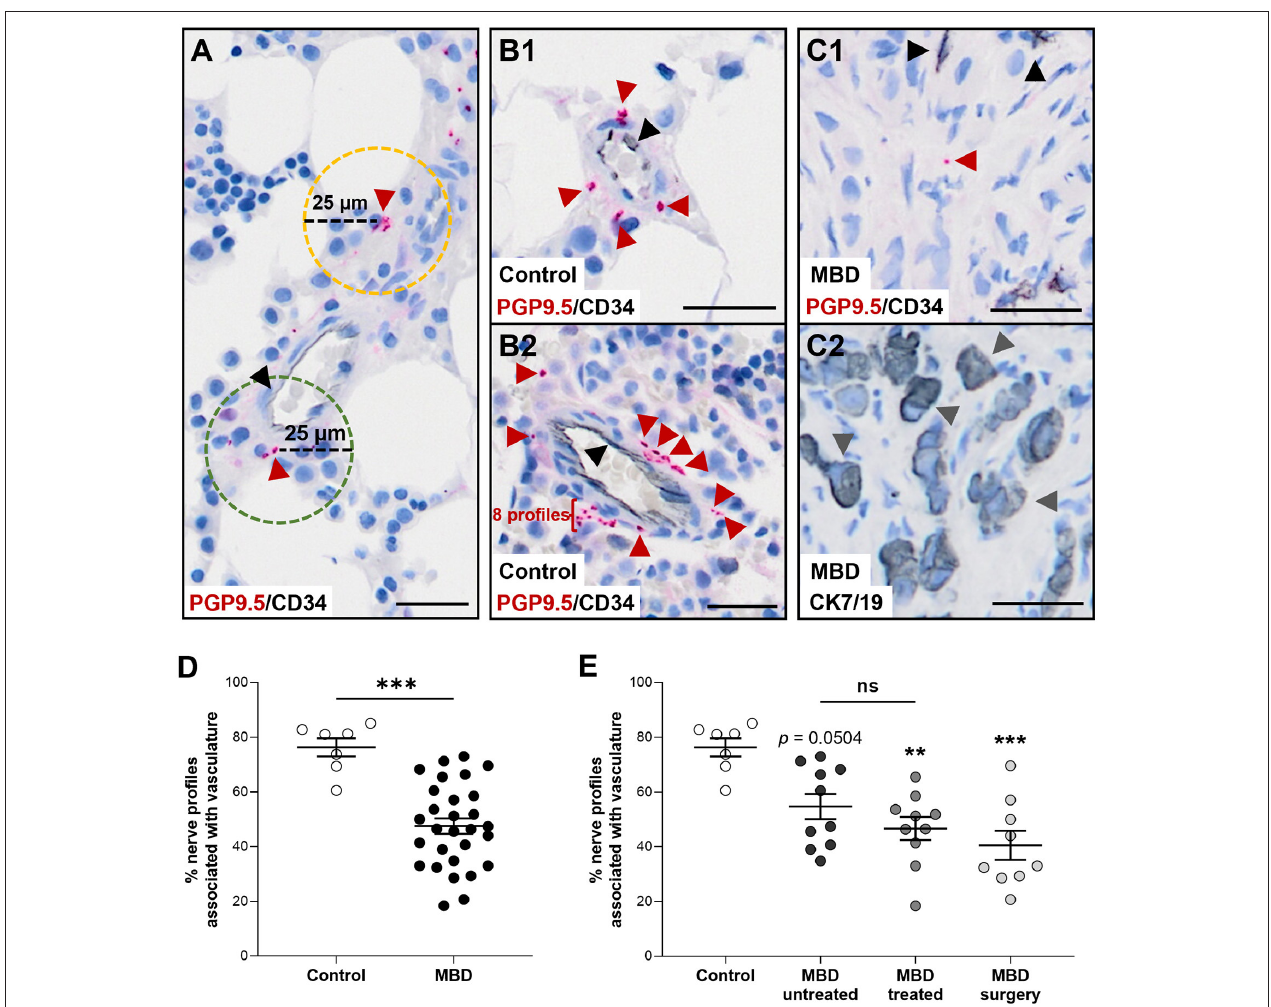
FIGURE 2 | Nerve profiles are less associated with vasculature in cancer-infiltrated bone. (A) For each nerve profile it was determined if it was associated within a distance of 25 µ m (green hatched line) or unassociated (yellow hatched line) with vasculature. (B,C) Representative illustrations of nerve profiles found within 25 µ m of a vascular structure in the bone marrow of human healthy tissue (B1,B2) and the bone marrow of patients with metastatic bone disease (MBD) (C1,C2) . Sections were stained for protein gene product 9.5 (PGP9.5, red arrow heads) and CD34-positive endothelial cells (black arrowheads), while the adjacent section was stained for cytokeratin 7 and 19 [CK7/19, gray arrow heads, (C2) ] to identify cancer cells. (D) The percentage of nerve profiles found proximate to a vascular structure was significantly higher in the healthy bone marrow compared to the cancer-infiltrated bone marrow. (E) Analysis of the three subgroups of cancer-infiltrated bone demonstrated a decreased association of nerve profiles and vascular structures in the MBD treated group and the MBD surgery group compared to controls. The comparison of healthy bone tissue with the MBD untreated subgroup did not reach significance ( p = 0.0504). Comparisons were performed with Mann-Whitney U test or Kruskal–Wallis one-way analysis of variance followed by Dunn’s multiple comparisons test as appropriate. Data are presented as mean ± SEM. ** p < 0.01, *** p < 0.001. Scale bars: 25 µ